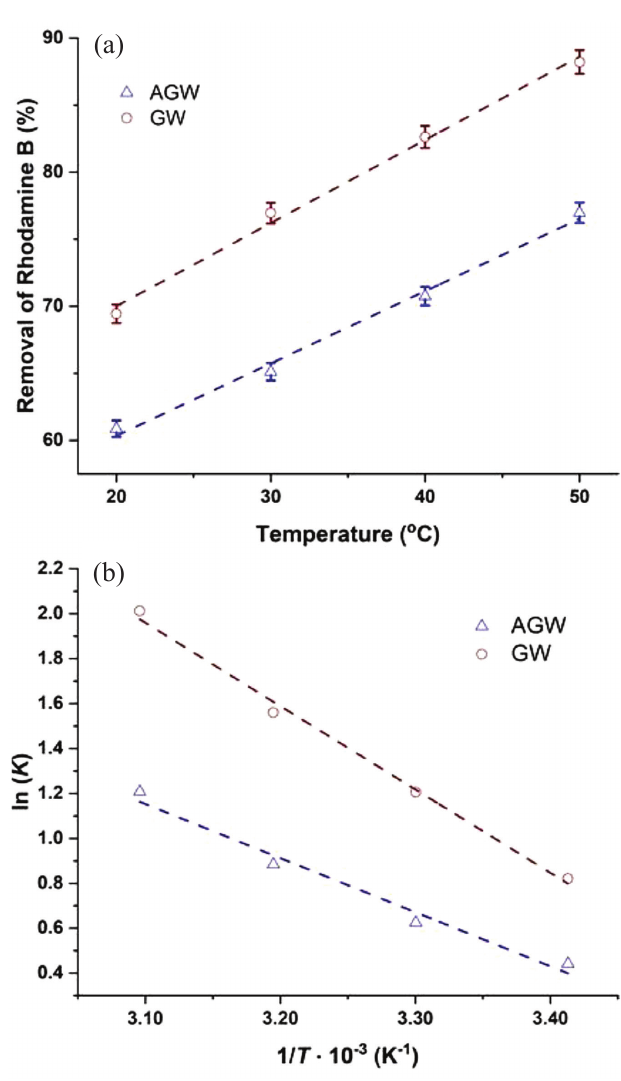
Fig. 6 – (a) Effect of temperature, and (b) Van’t Hoff plot for thermodynamic